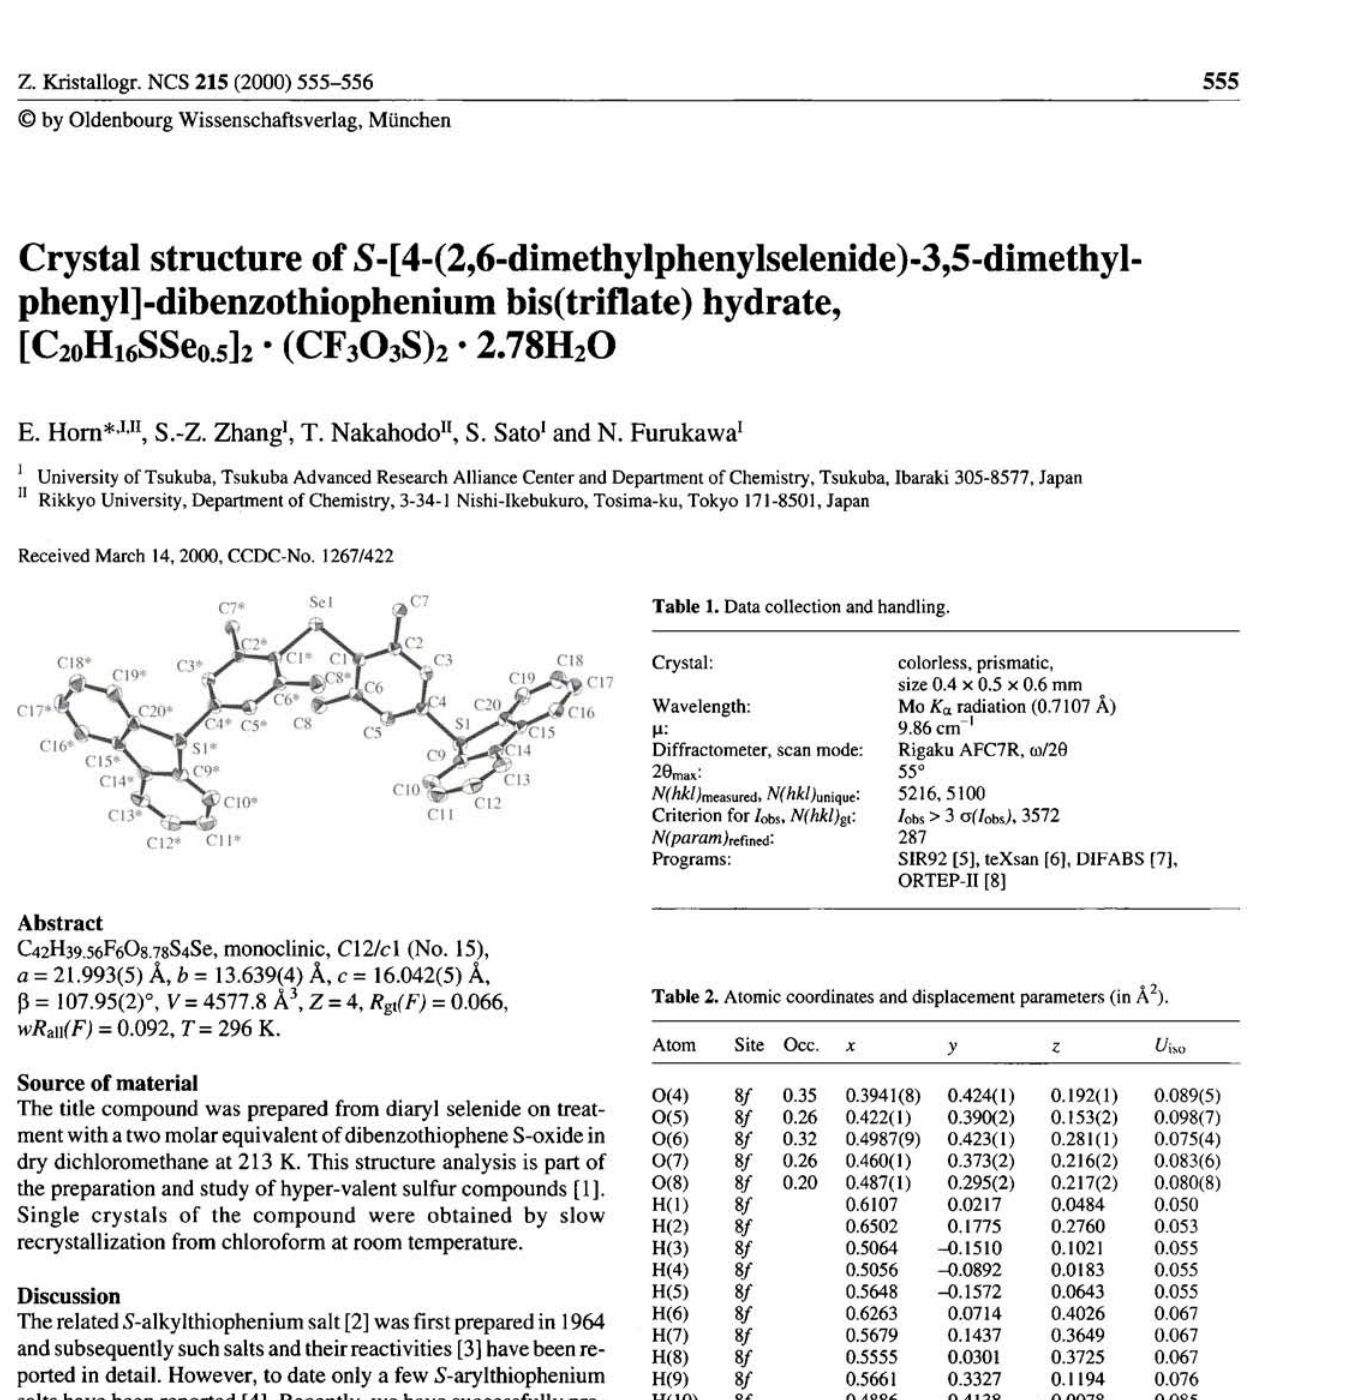
Table 2. Atomic coordinates and displacement parameters (in Ä 2